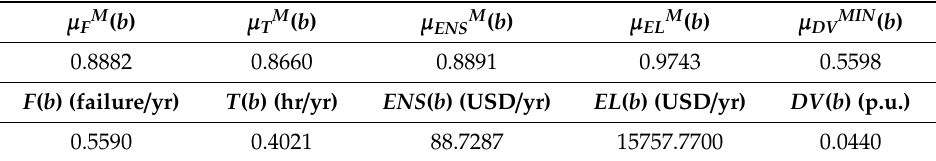
Table 7. Mean / minimum values of objectives before NR.